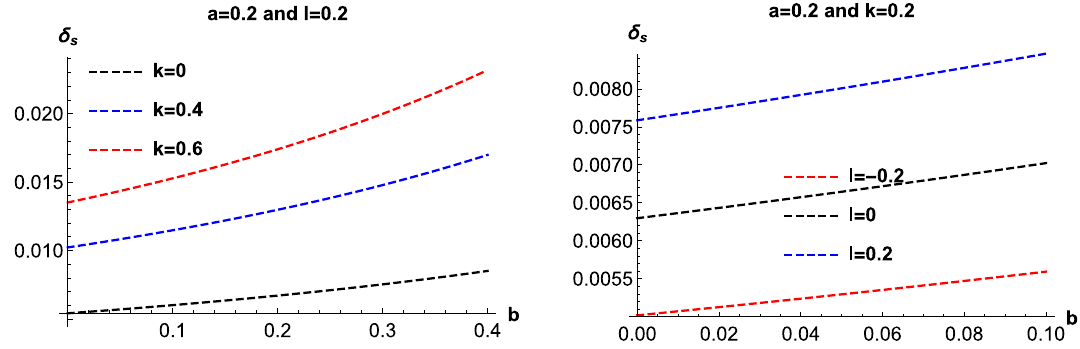
Fig. 13 The figure at the left side represent the variation of deviation from circularity δ s with b for different values of k with a = 0 . 2 and l = 0 . 2. The figure at the right side represents the variation of δ s with b for different values of l with a = 0 . 2 and k = 0 . 2